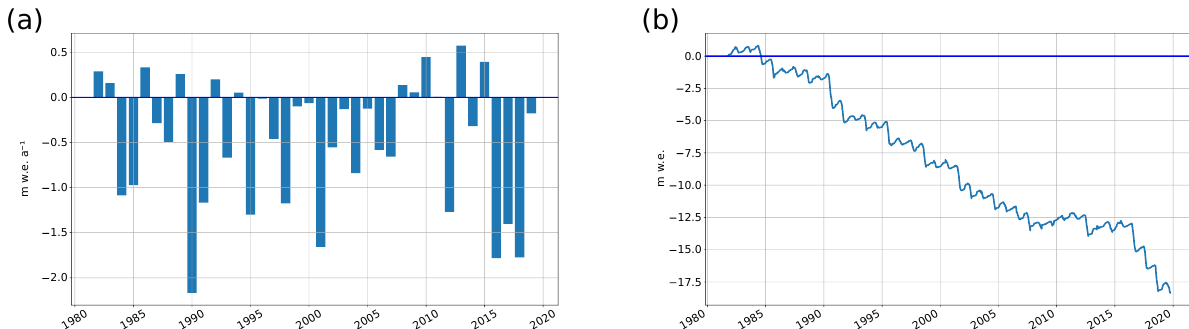
Figure 6. Simulated annual glacier-wide climatic mass balance ( a ) and cumulative ( b ) glacier-wide climatic mass balance of the Halji glacier from 1982 to